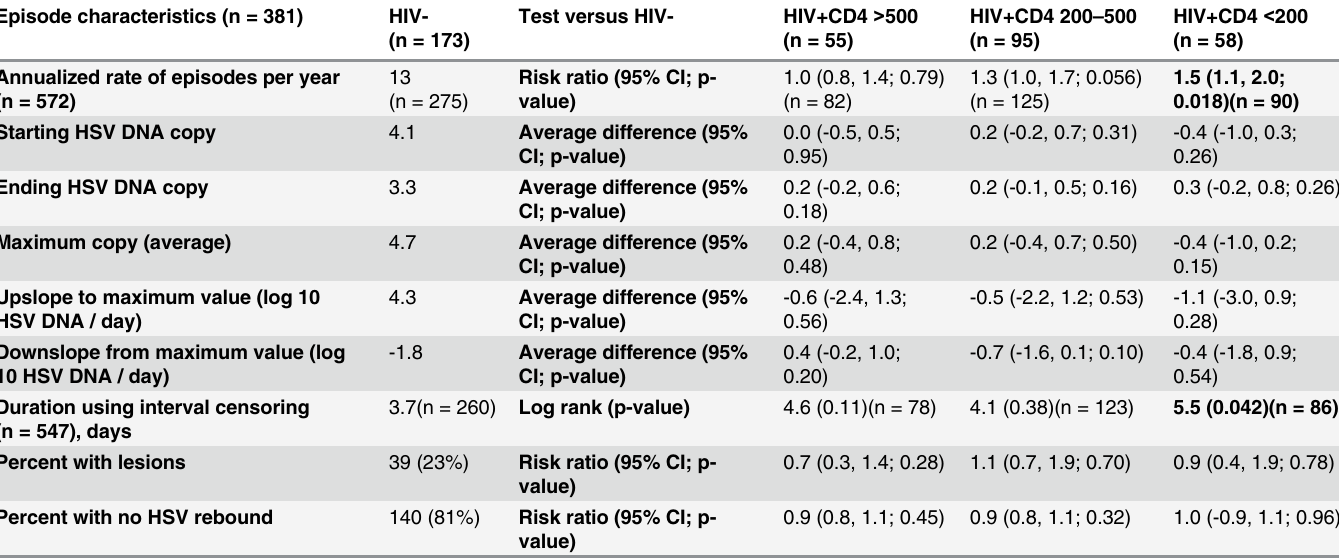
Table 2. Episode characteristics. Rate outcomes were compared by arm between persons using generalized estimating equations with a log link. Continu- ous outcomes were compared using generalized estimating models with an identity link. Significant differences are noted in bold and are limited to differences in episode rate and episode duration. All other episode characteristics are equivalent across cohorts.